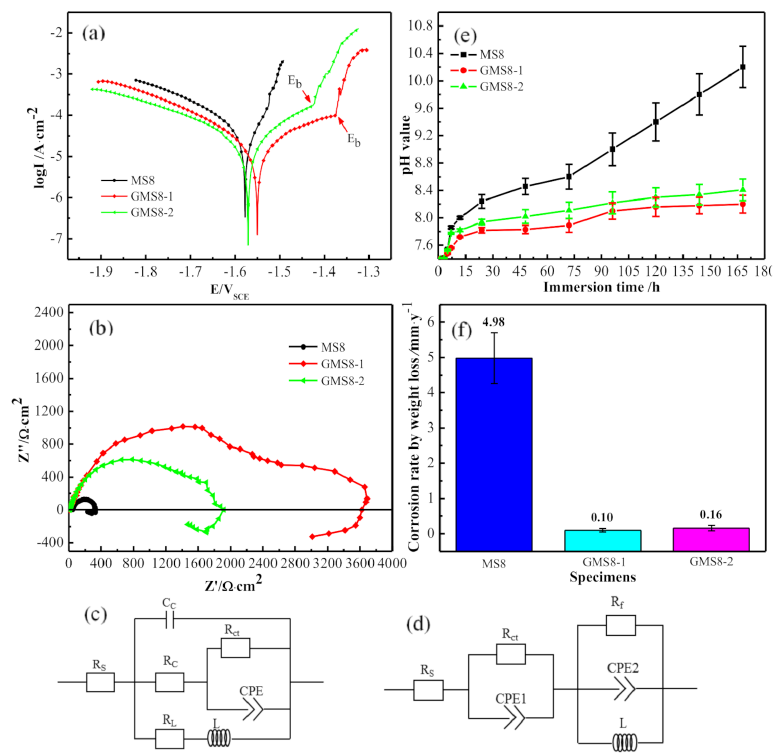
Figure 3. Potentiodynamic polarization curves of specimens ( a ); Nyquist plots of specimens ( b ); equivalent circuit of specimens MS8 ( c ), GMS8-1 and GMS8-2 ( d ); pH value of PBS solutions with specimens soaked for 7 days ( e ); corrosion rate by weight loss for 7 days ( f